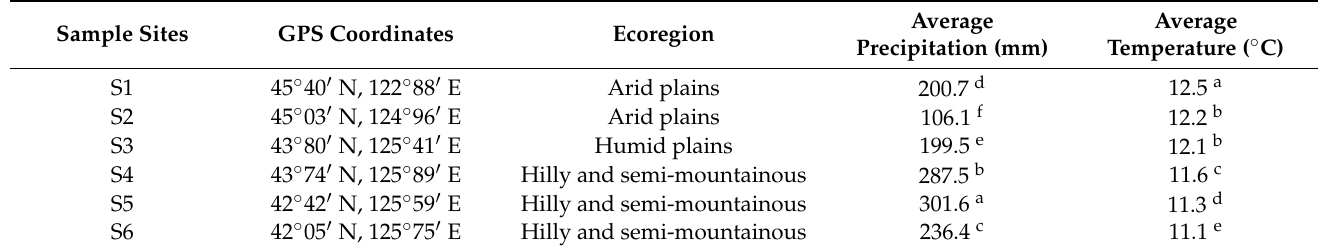
Table 1. Site description of study sites in Jilin